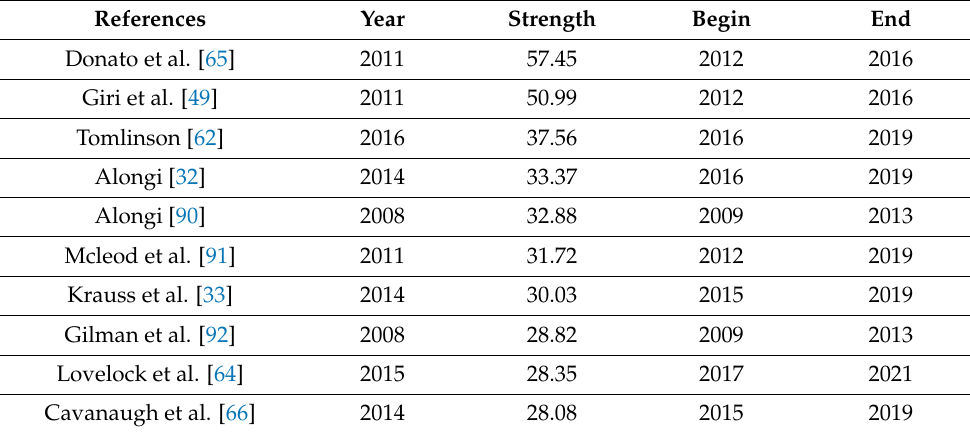
Table 7. Top 10 references with the strongest citation